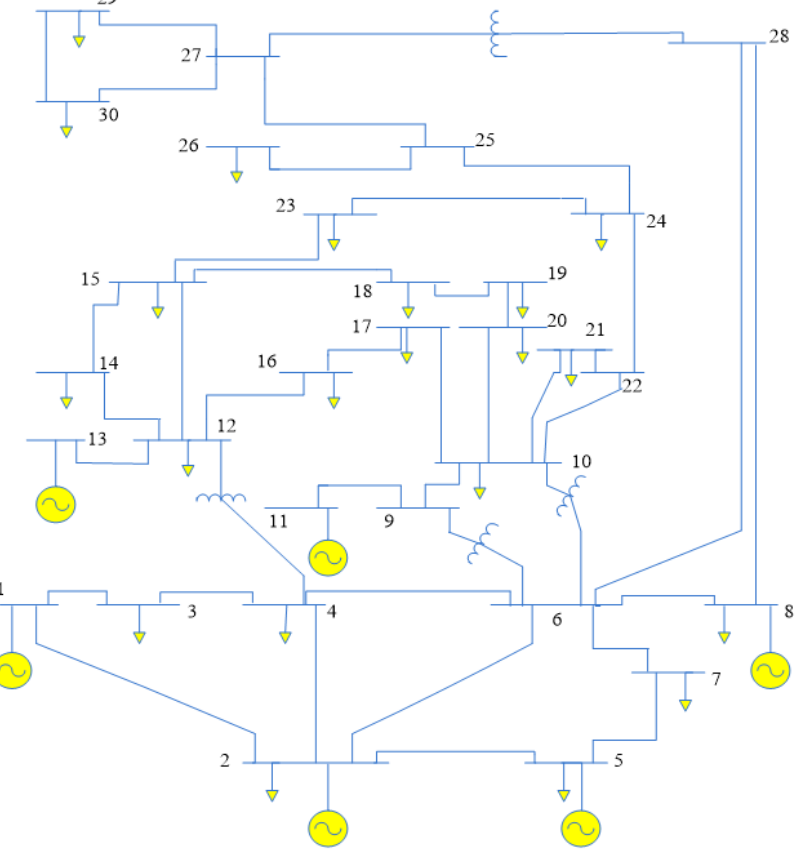
Figure 2. The IEEE 30-bus system.